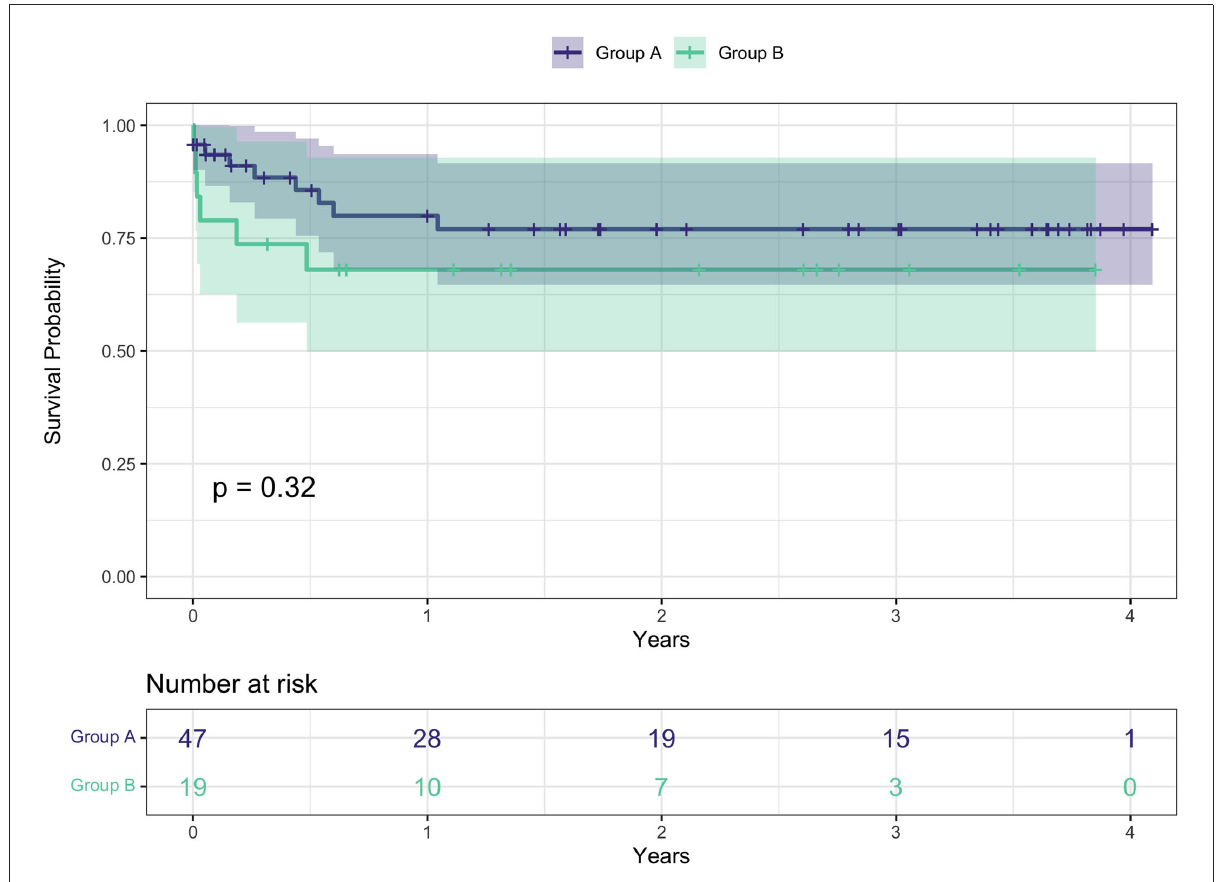
FIGURE3 Kaplan-Meier survival curves between the two groups. Group A: age at surgery < 70 years; group B: age at surgery ≥ 70.